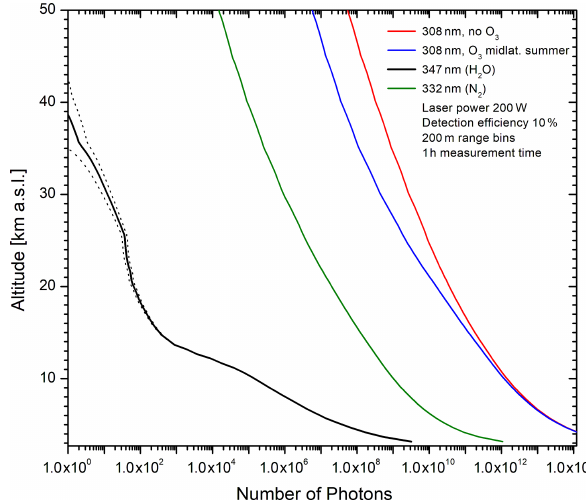
Figure 1. Simulations of the backscatter signals for four wave- lengths specified in the upper right corner; an average laser power at 308nm of 200W, a receiver diameter of 1.5m, a detection effi- ciency of 10%, a range bin of 200m and a measurement time of 1h were